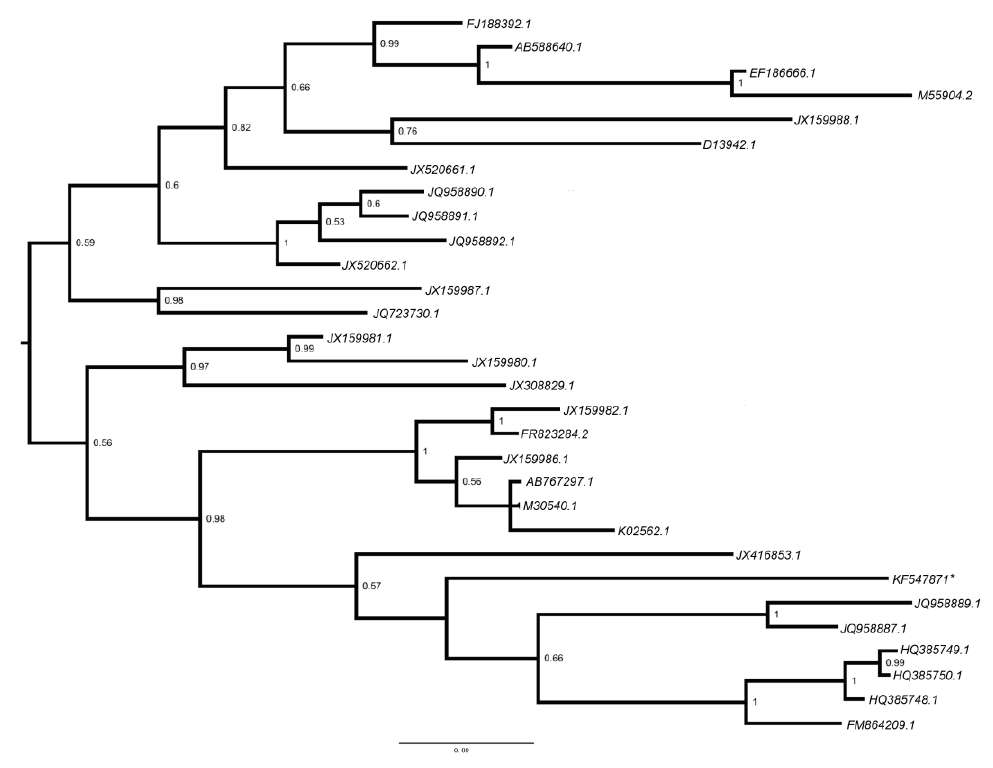
Figure 4. Phylogenetic analysis of polyomaviral contig. The midpoint-rooted phylogenetic tree based on 111 aa VP1 protein of polyomavirus (starred). Posterior probability values are shown at each node and the bar represents the expected number of amino acid substitutions per